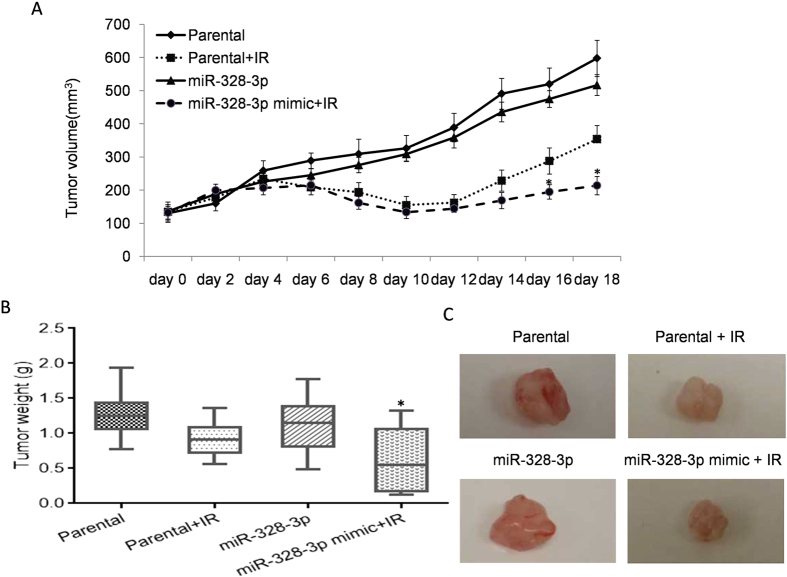
miR-328-3p sensitive tumour radiation response in vivo.(A) Nude rats (n = 10 each group) were subcutaneously injected with cells carrying miR-328-3p mimic or control. Tumour volumes were measured every two days. Following 8 Gy irradiation, over-expression of miR-328-3p significantly inhibited tumour growth compared to the parental cells. *p < 0.05 compared to the parental control with an IR. (B) Quantitative summary of the tumour weights. Data presented as mean ± SEM of the three independent experiments. *p < 0.05 compared to the parental control. (C) Characteristic image of tumours obtained from the xenograft model after exposure to irradiation.